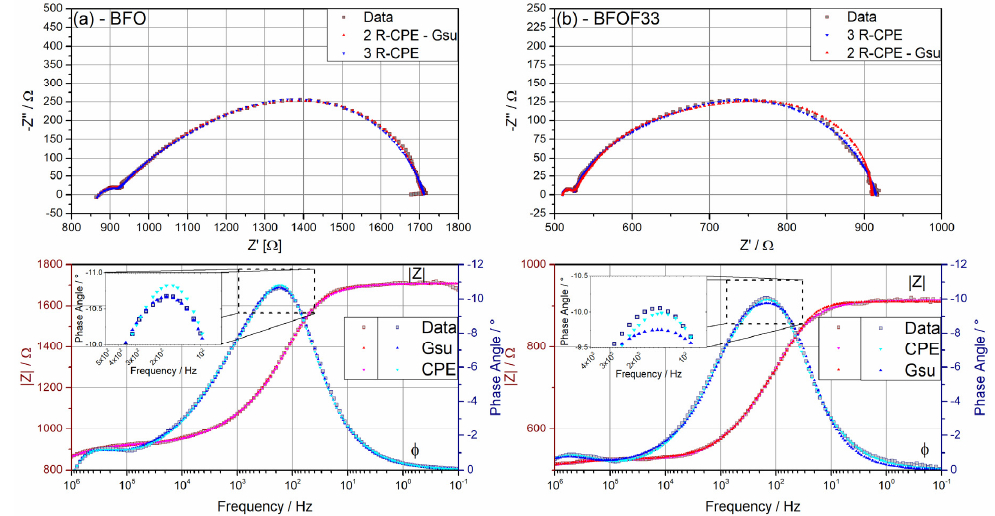
Figure 13. Comparison of fitting models describing diffusive and/or capacitive responses for ( a ) BFO’ and ( b ) BFOF33, where each, ( a ) and ( b ), contain a comparison of the used models inside Nyquist and Bode plots.